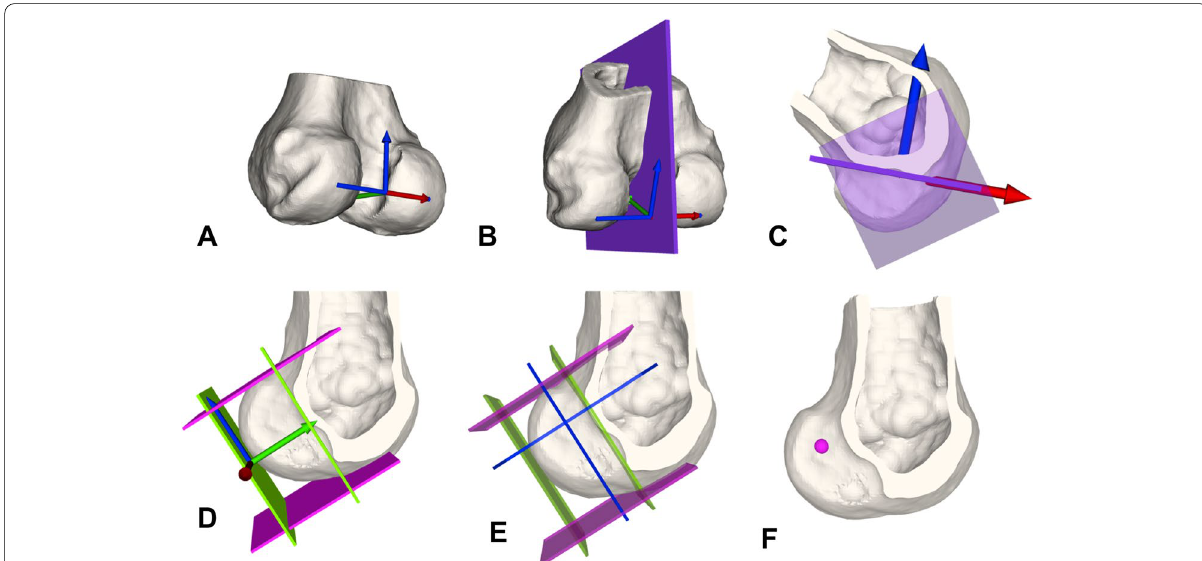
Fig. 2 Femoral ACL insertion. Definition of 3D femoral ACL insertion based on Bernard et al. [2] and described in the